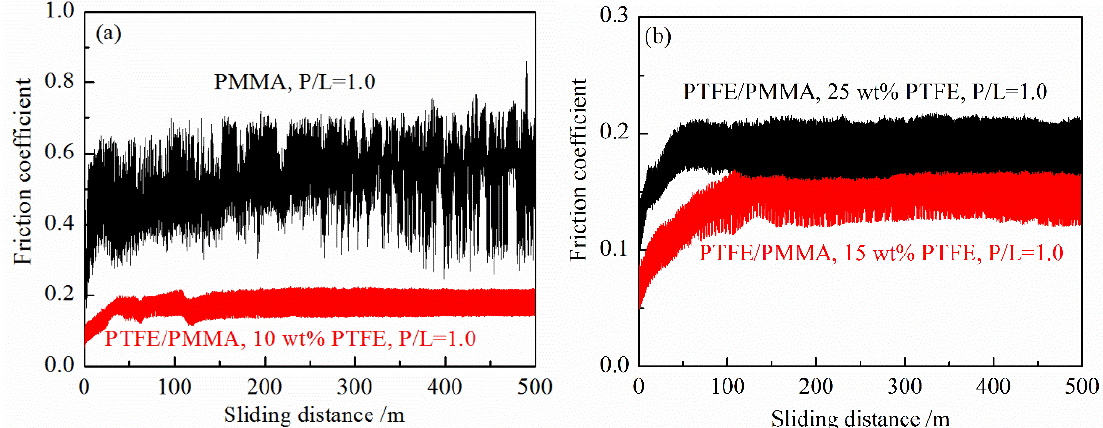
Figure 6. Friction coefficient changes with sliding distance. ( a ) PMMA and 10 wt % PTFE filled PMMA and ( b ) 15 wt % and 25 wt % PTFE filled PMMA.